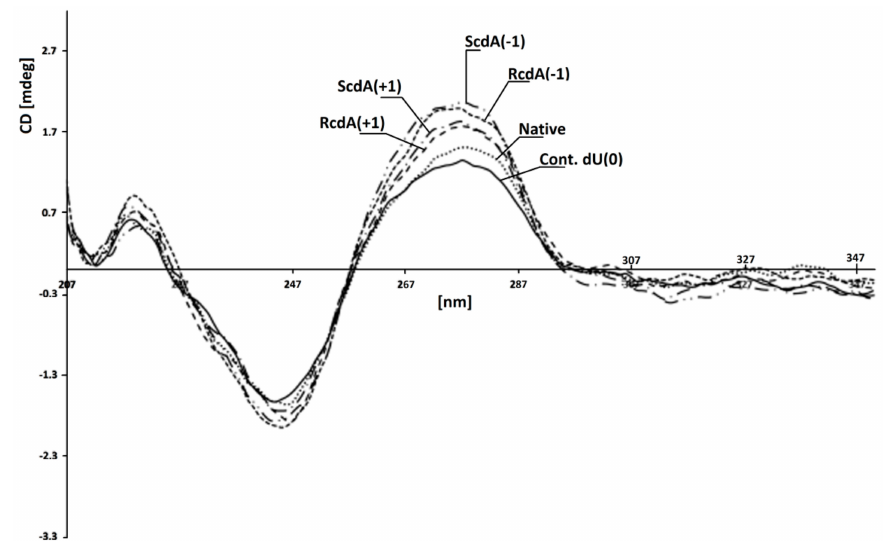
Figure 4. CD spectra of investigated ds -oligonucleotides in 0.1 M NaCl with 0.01 M MgCl 2 .